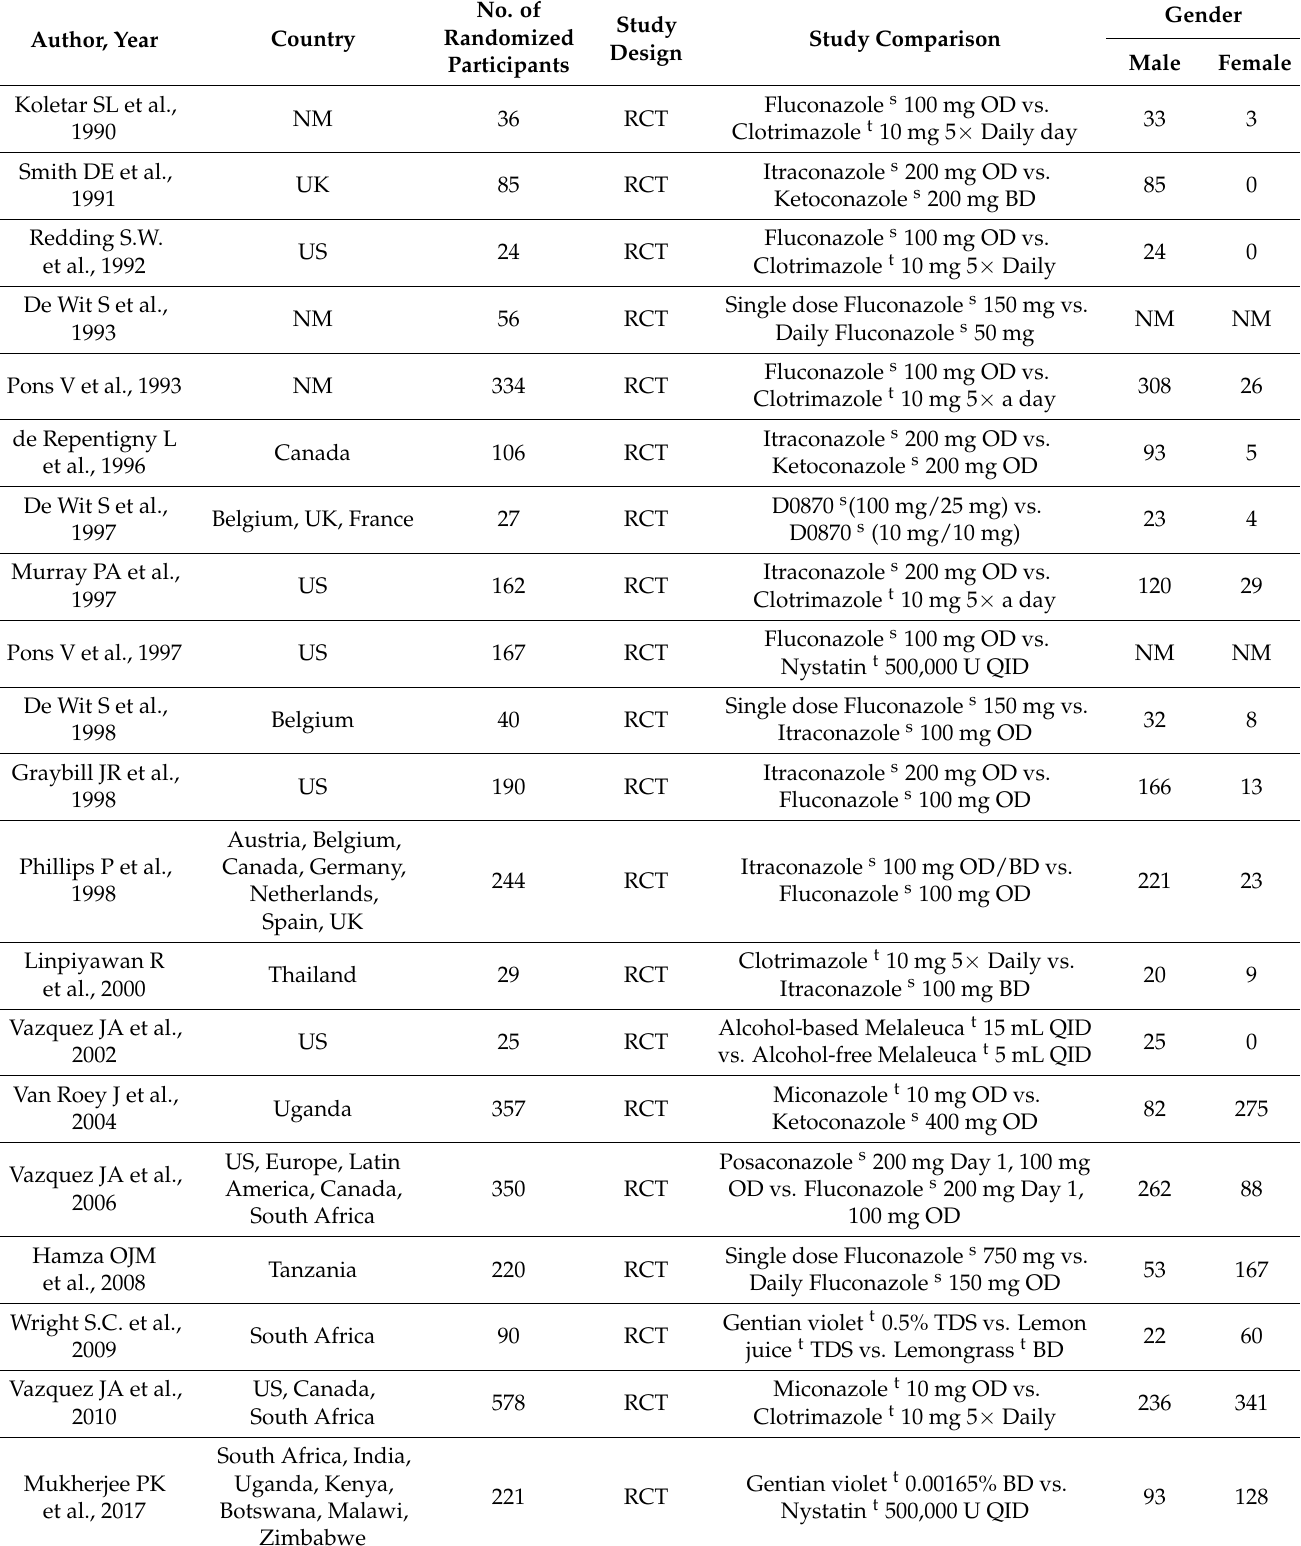
Table 1. Characteristics of the included studied in